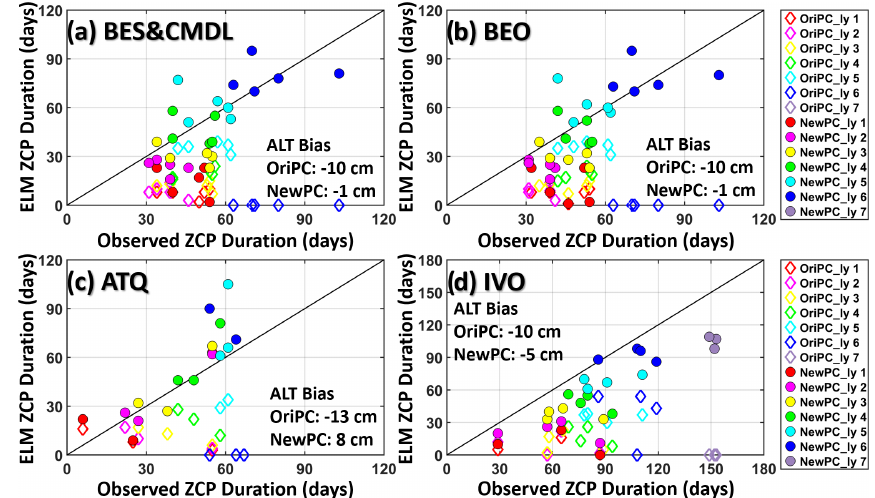
Figure 3. Comparison between observed and ELMv1-ECA simulated durations of ZCP for the original (OriPC; open diamonds) and im- proved (NewPC; solid circles) phase-change schemes over four annual cycles (July to June) from 2013 to 2017. “ly” means model layer. Simulated ZCP durations with NewPC demonstrate significant improvements compared to OriPC (solid dots vs. open diamonds), especially for the fourth to the deepest layer above permafrost. Note that a zero-day ZCP means that the maximum daily temperature during an annual cycle is below 0 ◦ C. The pairs of zero vs. non-zero-day ZCP (e.g., OriPC_ly 7 at IVO and OriPC_ly 6 at other sites) indicate that baseline results underestimated ALT. The bias (simulation − observation) of multi-year averaged ALT simulated by the two experiments is provided in each panel.